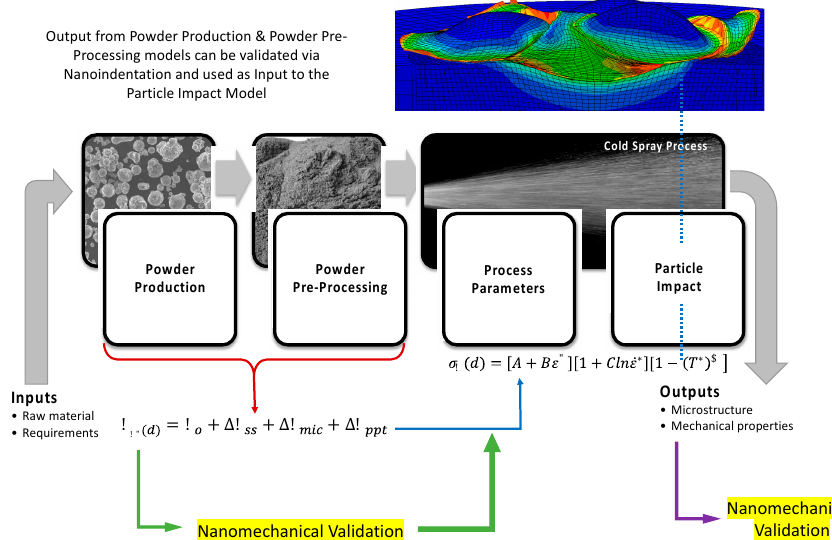
Figure 56. Simple schematic illustrating through-process modeling of cold spray and areas wherein nanomechanical assessment and model validation can play a role.